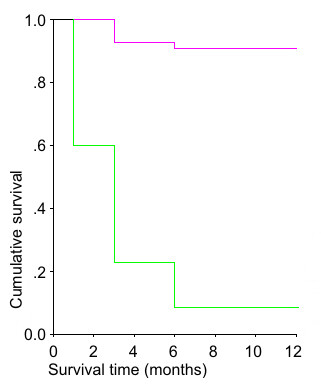
Patients with serum AHSG concentration < 365 μg/ml have lower survival rate than those with ≥ 365 μg/ml throughout the 1-year observation period. Serum AHSG concentration < 365 μg/ml (green line, n = 35), serum AHSG concentration ≥ 365 μg/ml (magenta line, n = 54), log rank test, p < 0.001